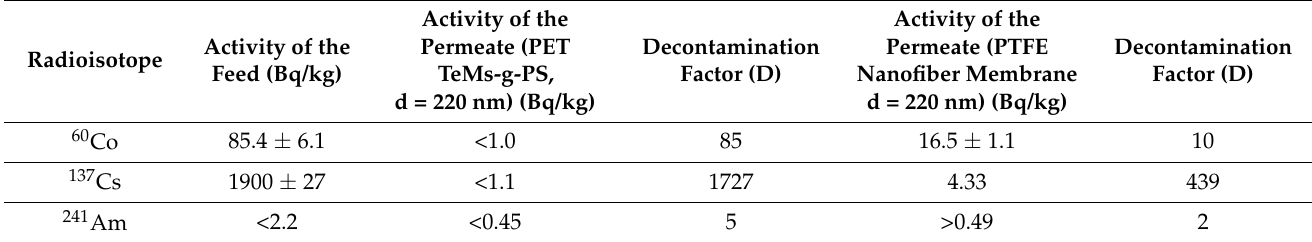
Table 4. Radioisotope composition of feed waste solution and permeate solution after DCMD process.